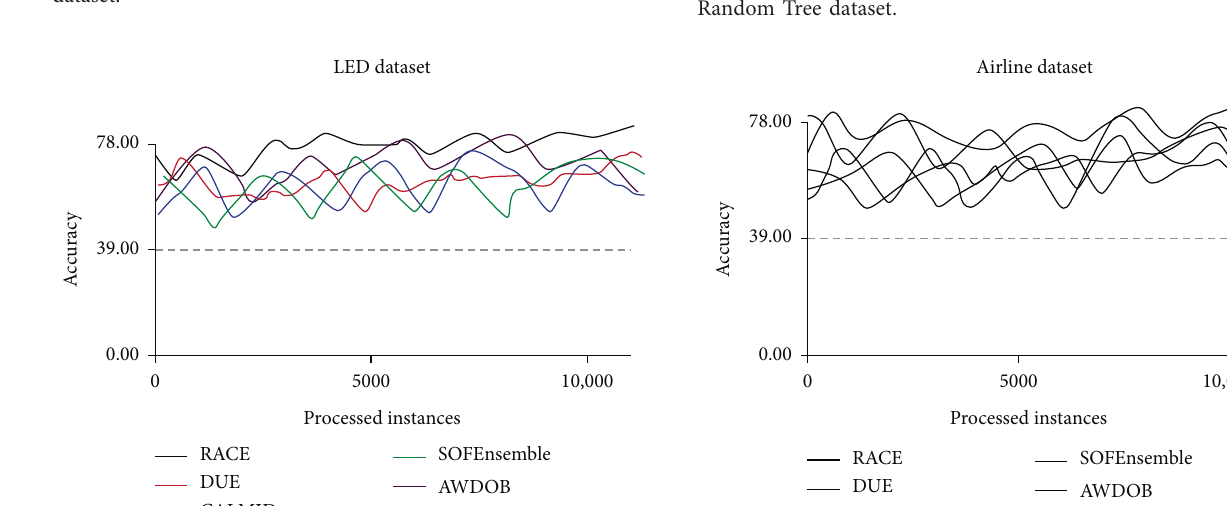
Figure 6: Prediction accuracy of the five algorithms on the Random Tree dataset.